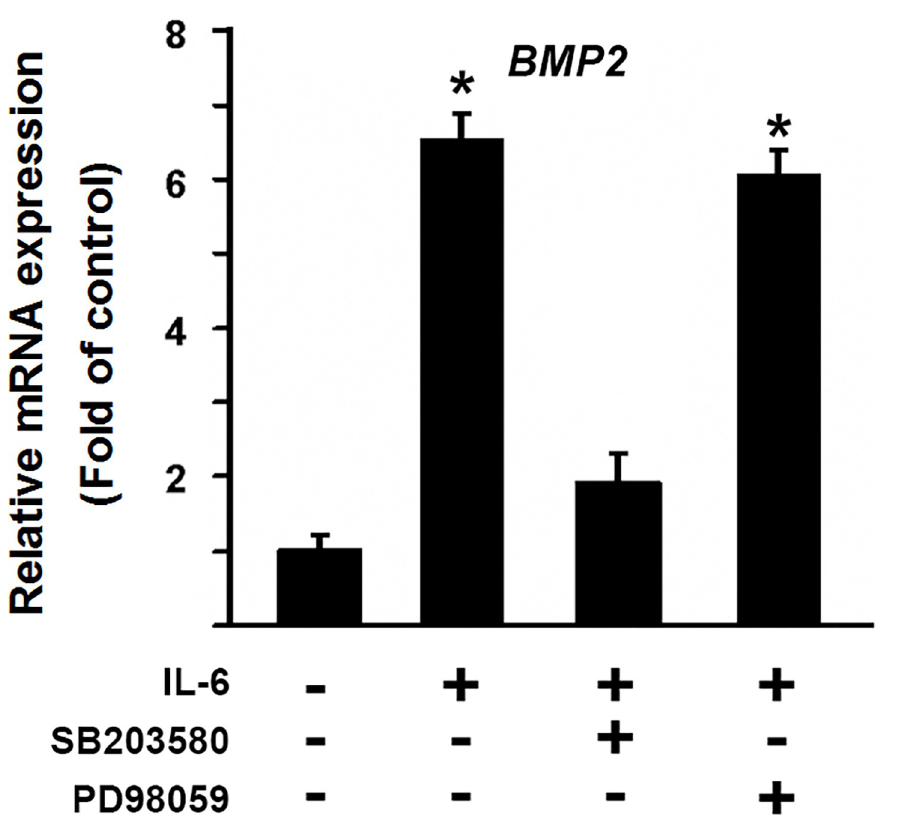
Fig 4. IL-6-induced BMP2 activation is mediated through p38 MAPK pathway. Gene expressions were determined via qRT-PCR in primary ligamentum flavum cells with or without IL-6 stimulation. Specific inhibitors (10 μ M SB203580 or 50 μ M PD98059) were added as